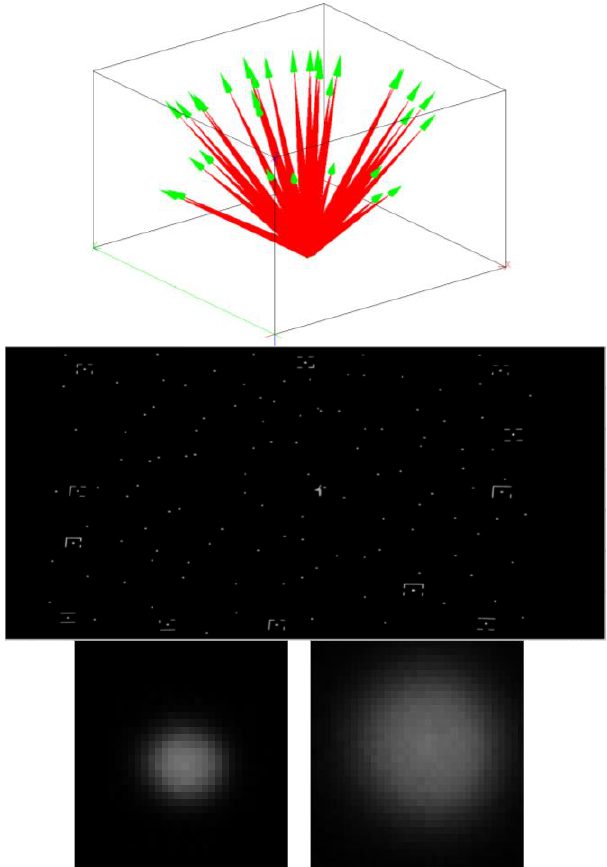
Figure 13. Camera calibration image network (top) where green cones denote photo positions and red lines denote lines of sight from each photo to each target on the Manhattan model, example image demonstrating full coverage of the sensor (middle), and sample target images (bottom), Violet (left) and IR